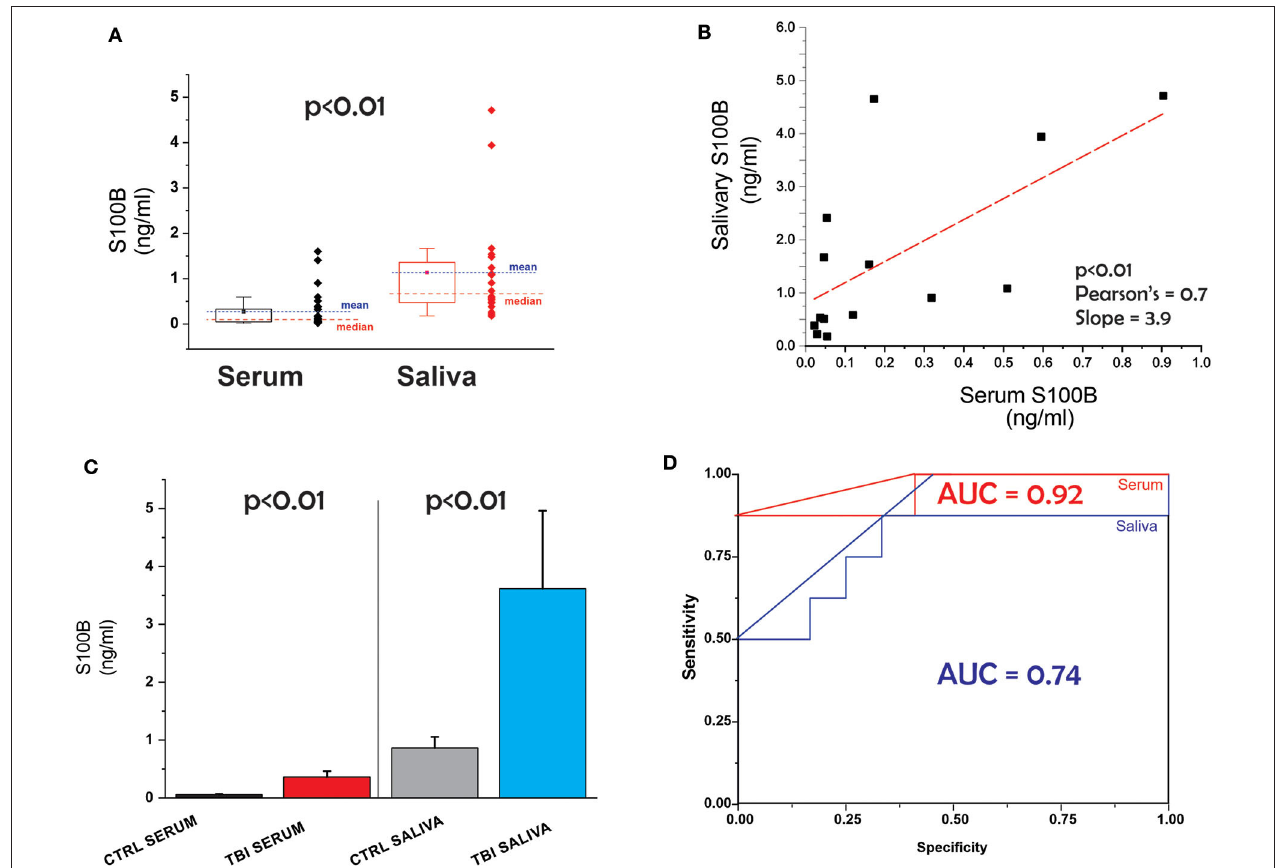
FIGURE 1 | (A) Serum and salivary levels of S100B in all subjects. Red and blue symbols differentiate between control and TBI. (B) Correlation between salivary and serum S100B. (C) Comparable predictive value for TBI of saliva and serum; (D) ROC curves for salivary and serum S100B.